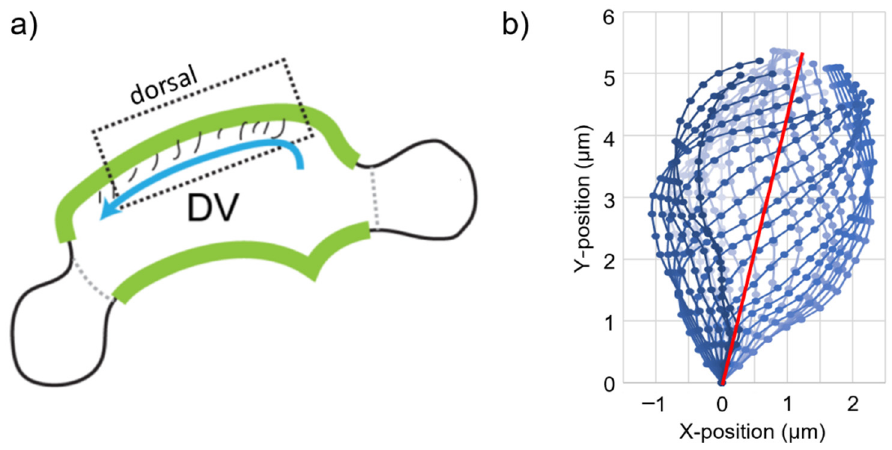
Figure 1. ( a ) The schematic of a brain ventricle for a 2 dpf zebrafish embryo. The blue arrow shows the flow direction. DV: Di-/mesencephalic ventricle. The green highlight indicates the location of motile cilia. ( b ) The averaged cyclic motion of one motile cilium. The color of the lines from light to dark reflects the progression of time in the cyclic motion. The red line shows the spatial mean of the cyclic motion and has an angle of 30 degrees with the Y-axis. The total time length of one cyclic motion was 0.033 s.